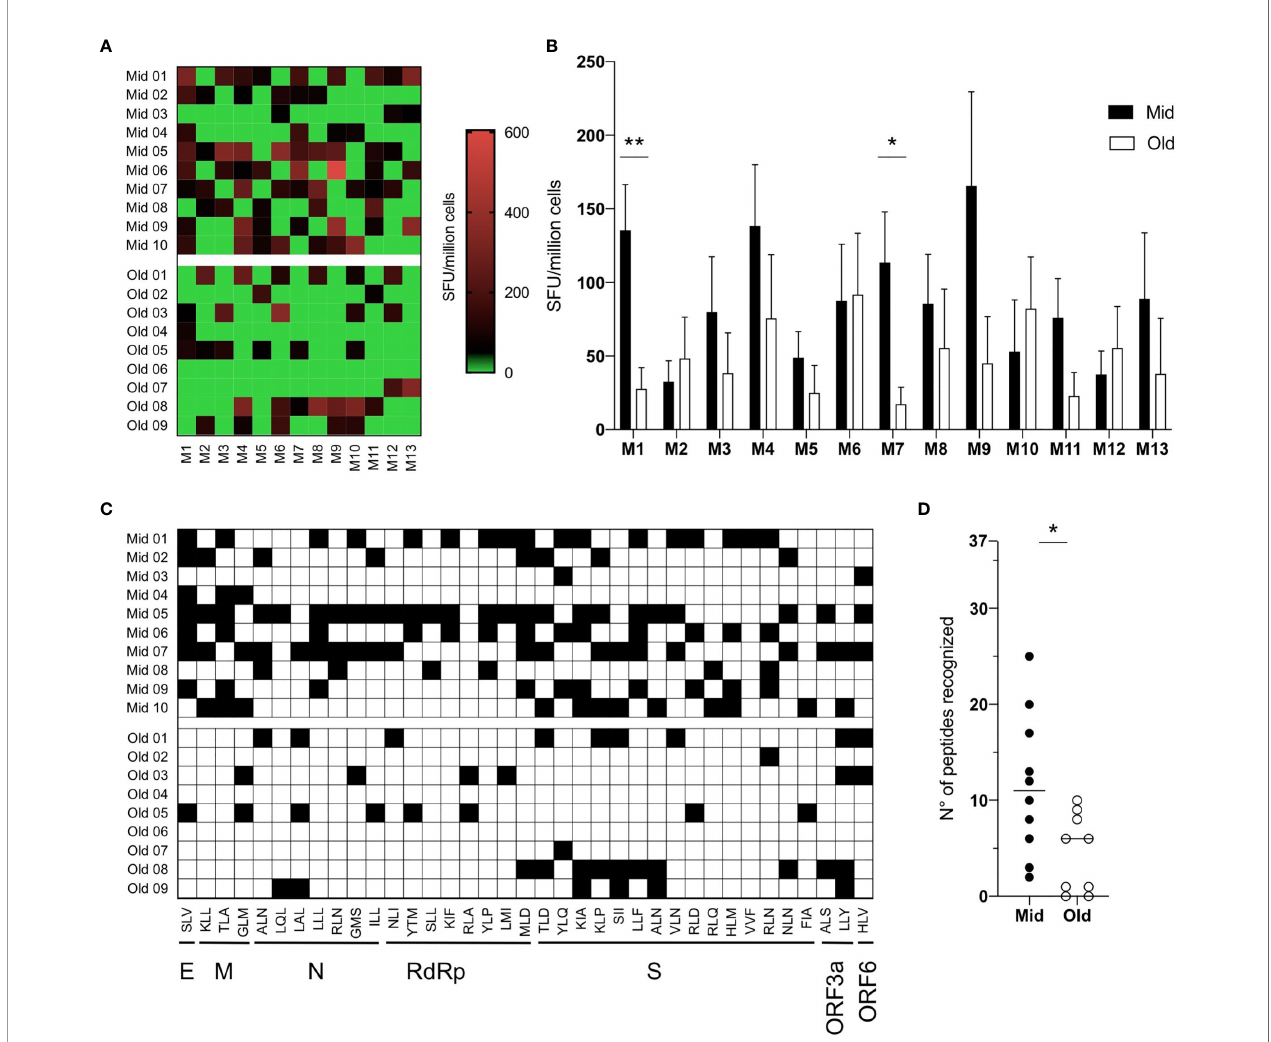
FIGURE 2 | Reduced antigenic repertoire of SARS-CoV-2 speci fi c primary CD8 + T-cell responses in older adults. (A – D) PBMCs (7 × 10 7 ) were primed in vitro with a pool of 37 SARS-CoV-2-derived peptides. After ten days, the frequency of epitope-speci fi c primed naive CD8 + T cells was measured upon restimulation with 12 different matrixes composed of six peptides each or with the YLQ peptide (matrix 13) by IFN g ELISpot. Responses above the threshold of 50 SFU/million cells were considered positive. Individual (A) and median values + S.E.M. (B) of responses to single matrixes are shown. Since each peptide is contained in two different matrixes, when responses to both matrixes were above 50 SFU/million cells, the response toward that single peptide was counted as positive and marked in black (C) . The total number of recognized peptides by each donor was calculated and shown (D) ; the lines represent the median values. Statistical signi fi cance was determined by Mann – Whitney test, *p < 0.05 and **p <